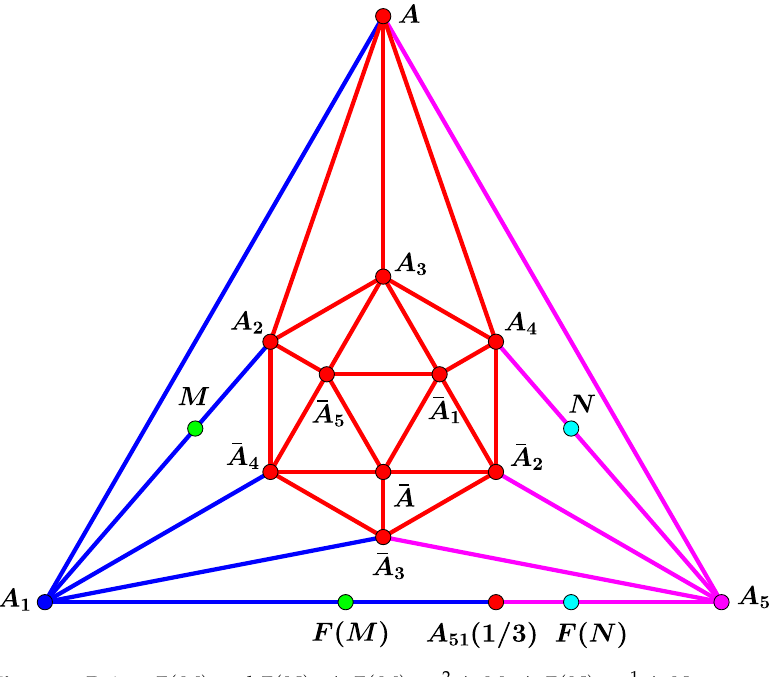
Figure 2. Points F ( M ) and F ( N ) : A 1 F ( M ) = 2